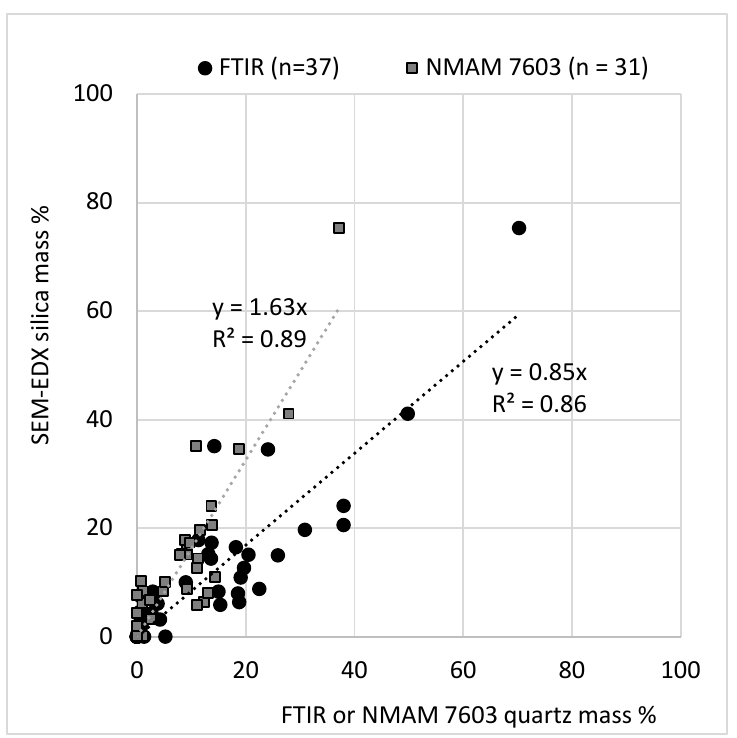
Figure 3. Correlation between the silica mass% estimated from SEM-EDX and quartz% measured by FTIR or NMAM 7603 for the pairs of respirable dust samples generated from primary source materials.